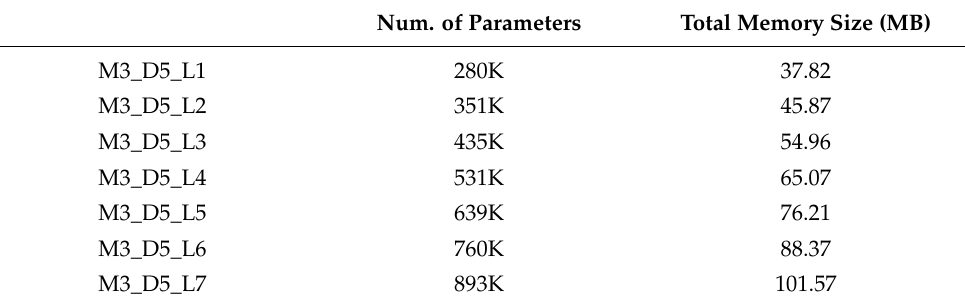
Table 8. Verification of the number of dense layer (L) per a dense block in terms of network complexity. Num. of Parameters